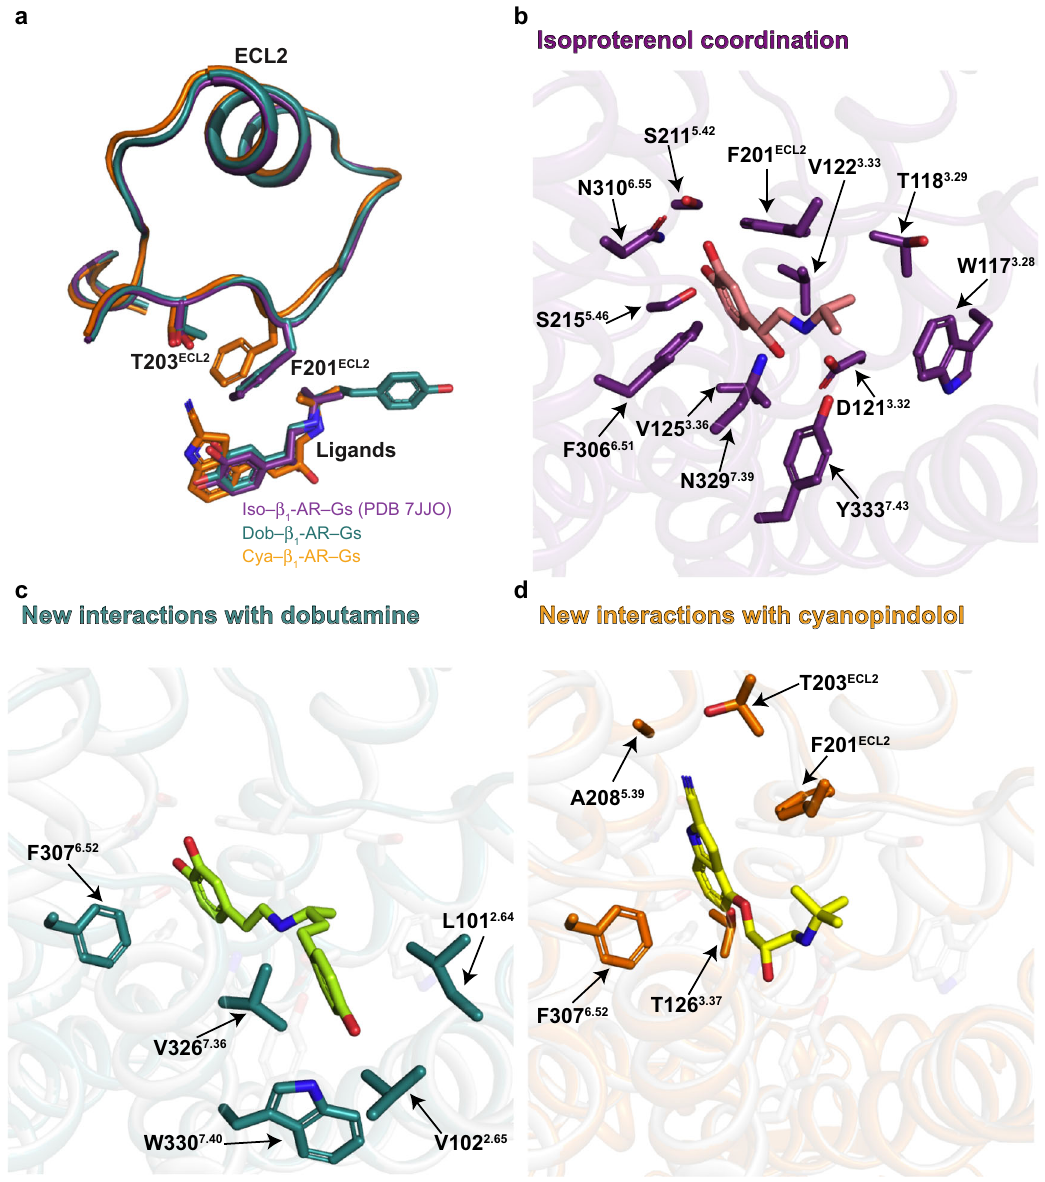
Fig. 2 Local conformational differences among the three complexes. a ECL2 segments from the three complexes are shown. While Phe201 ECL2 is involved in the binding to all three ligands, Thr203 ECL2 is only engaged in cyanopindolol interaction. The color codes: Purple: Iso – β 1 -AR – Gs; Green: Dob – β 1 -AR – Gs; Orange: Cya – β 1 -AR – Gs. b Diagram of the ligand-binding residues in the isoproterenol-bound β 1 -AR – Gs complex. c Additional ligand-binding residues in the dobutamine-bound β 1 -AR – Gs complex, comparing with the isoproterenol-bound β 1 -AR – Gs complex. d Additional ligand-binding residues in the cyanopindolol-bound β 1 -AR – Gs complex, comparing with the isoproterenol-bound β 1 -AR – Gs